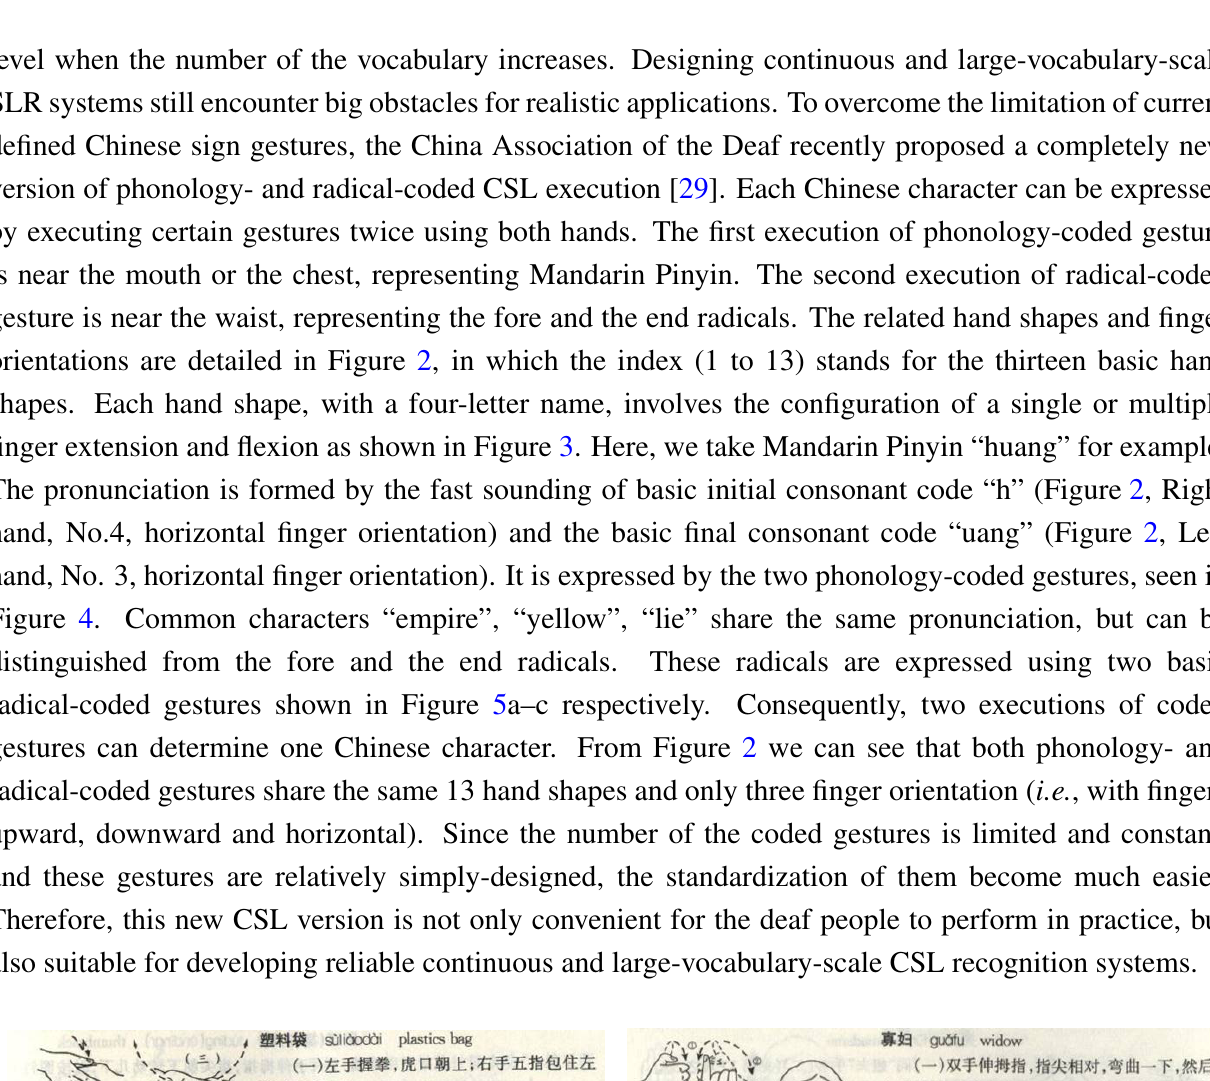
Figure 4. Common characters “empire”, “yellow”, “lie” share the same pronunciation, but can be distinguished from the fore and the end radicals.